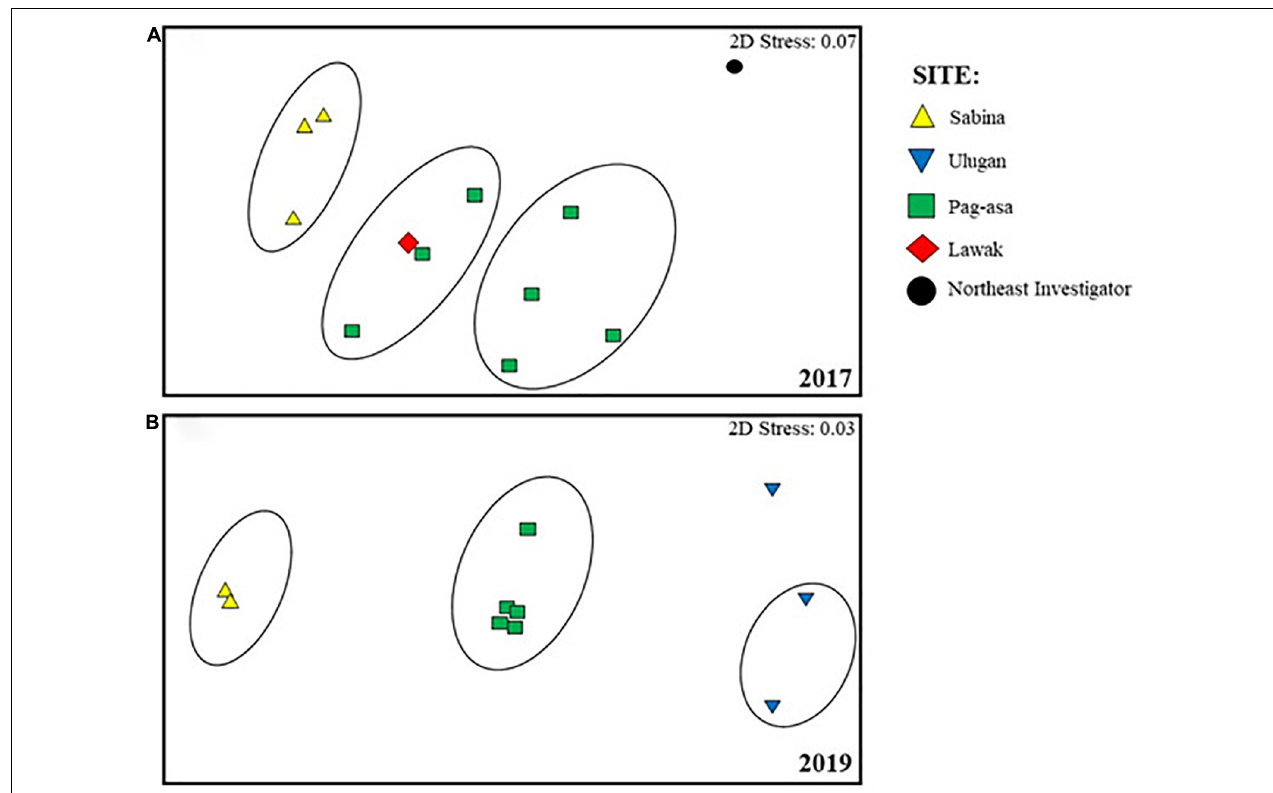
FIGURE 4 | Non-multidimensional scaling ordination based on the Bray-Curtis similarity index, showing differences in the octocoral assemblages in different stations in Kalayaan Island Group (Pag-asa, Sabina, Lawak and Northeast Investigator) and Ulugan, surveyed in (A) 2017 and (B) 2019. Eclipses indicate stations with more than 40%